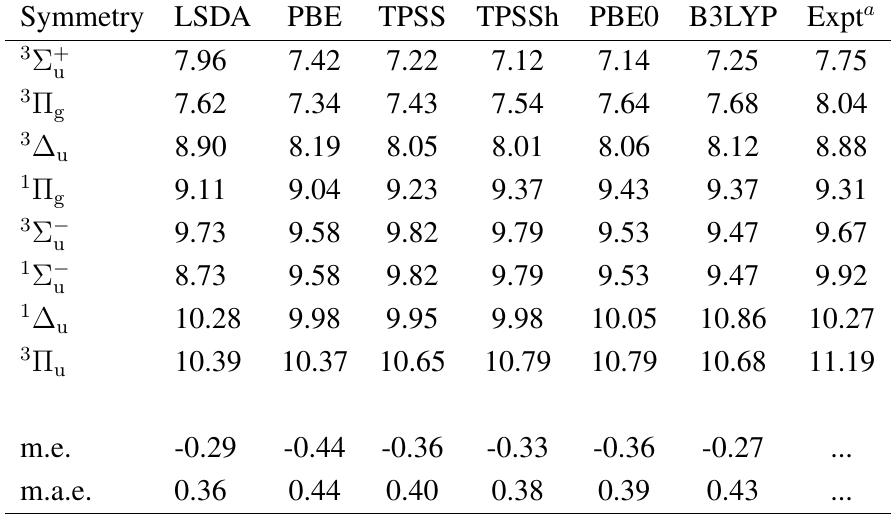
. The mean experimental value is 9.38 eV. 2